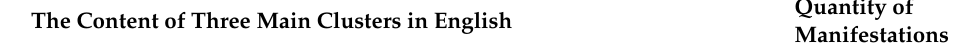
Table 7. Results in detail of three major word